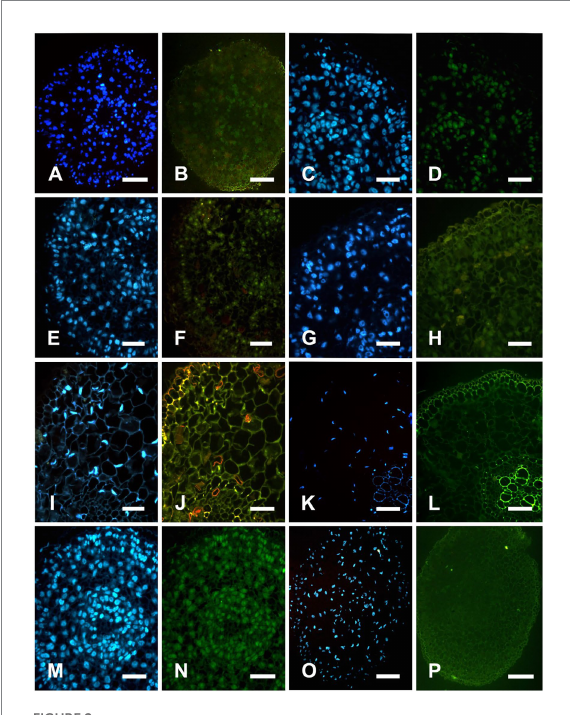
FIGURE 2 TUNEL and DAPI detect nuclear DNA fragmentation in Nelumbo nucifera roots. DAPI is a fluorescent dye that can strongly bind to DNA for nuclear staining. TUNEL assay can detect the cleavage of nuclear DNA During apoptosis, the apoptotic cells or TUNEL-positive cells can be specifically